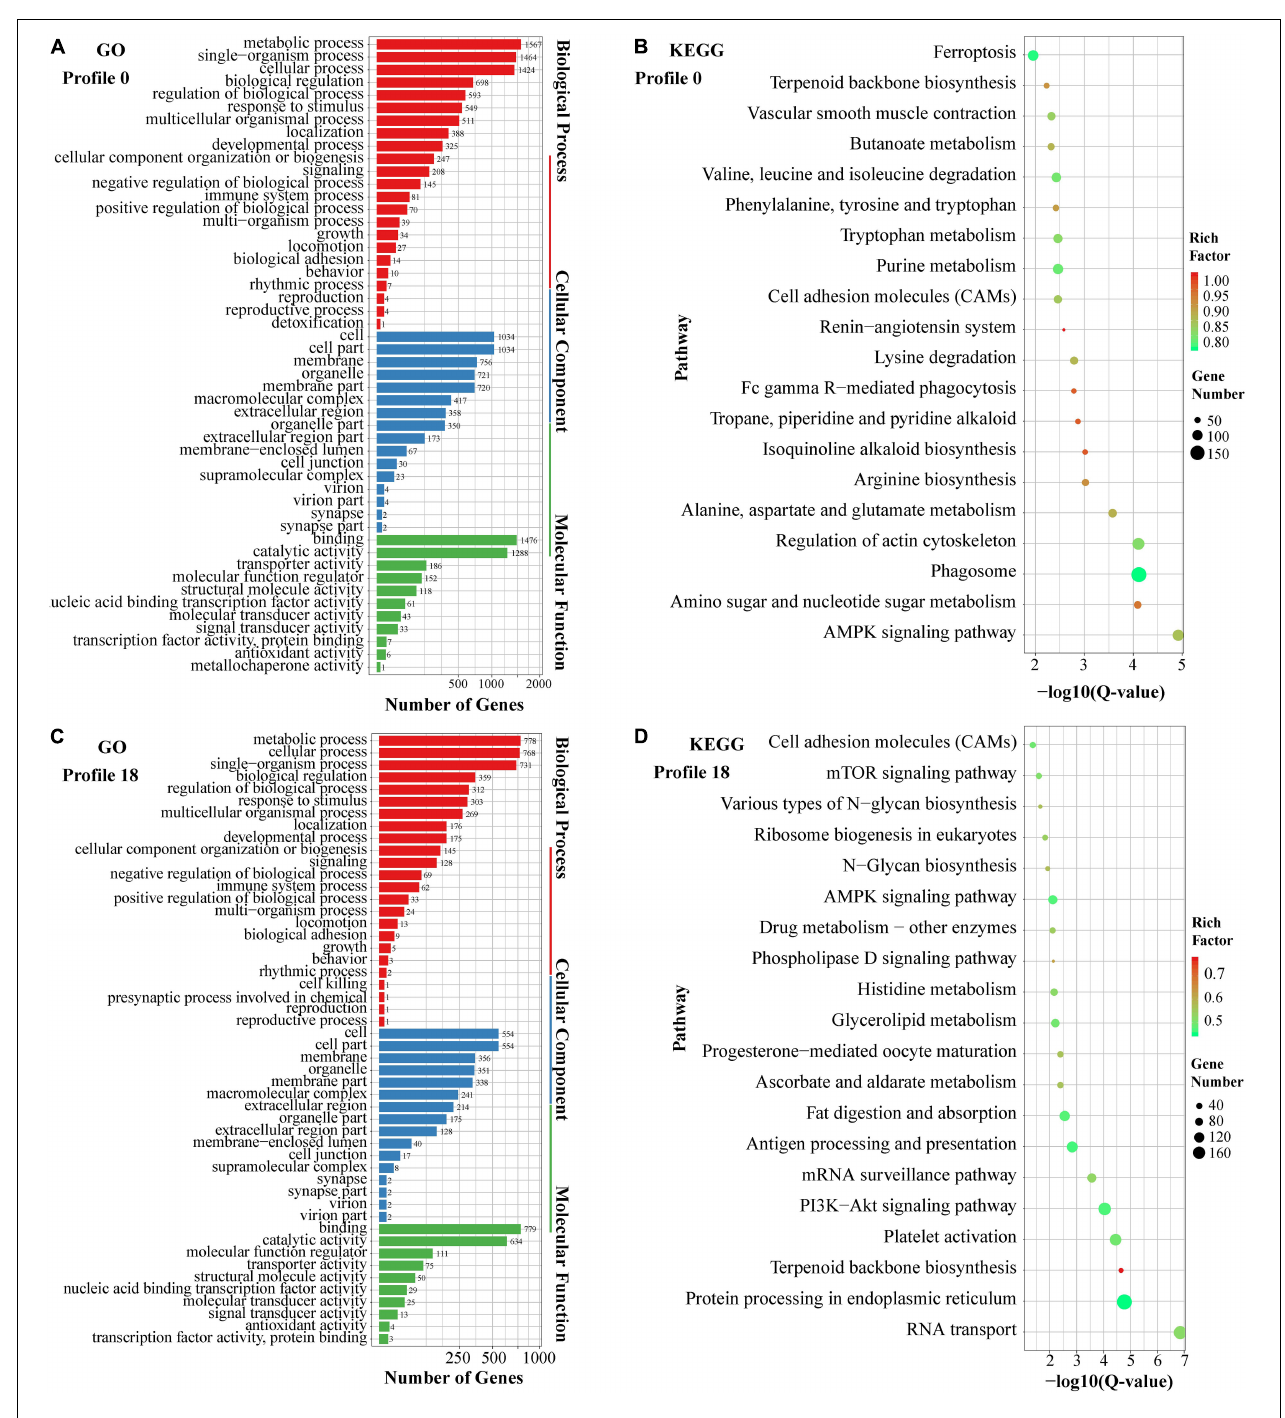
FIGURE 7 | Summary of GO and KEGG pathway enrichment analyses of the miRNA target genes in profiles 0 (A,B) and 18 (C,D) .